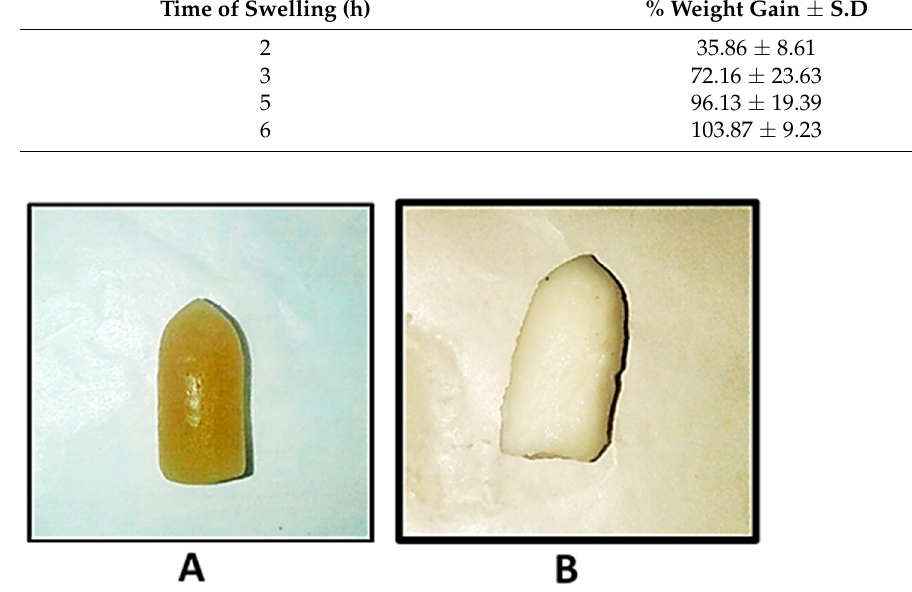
Table 2. % weight gain of suppositories in SVF.